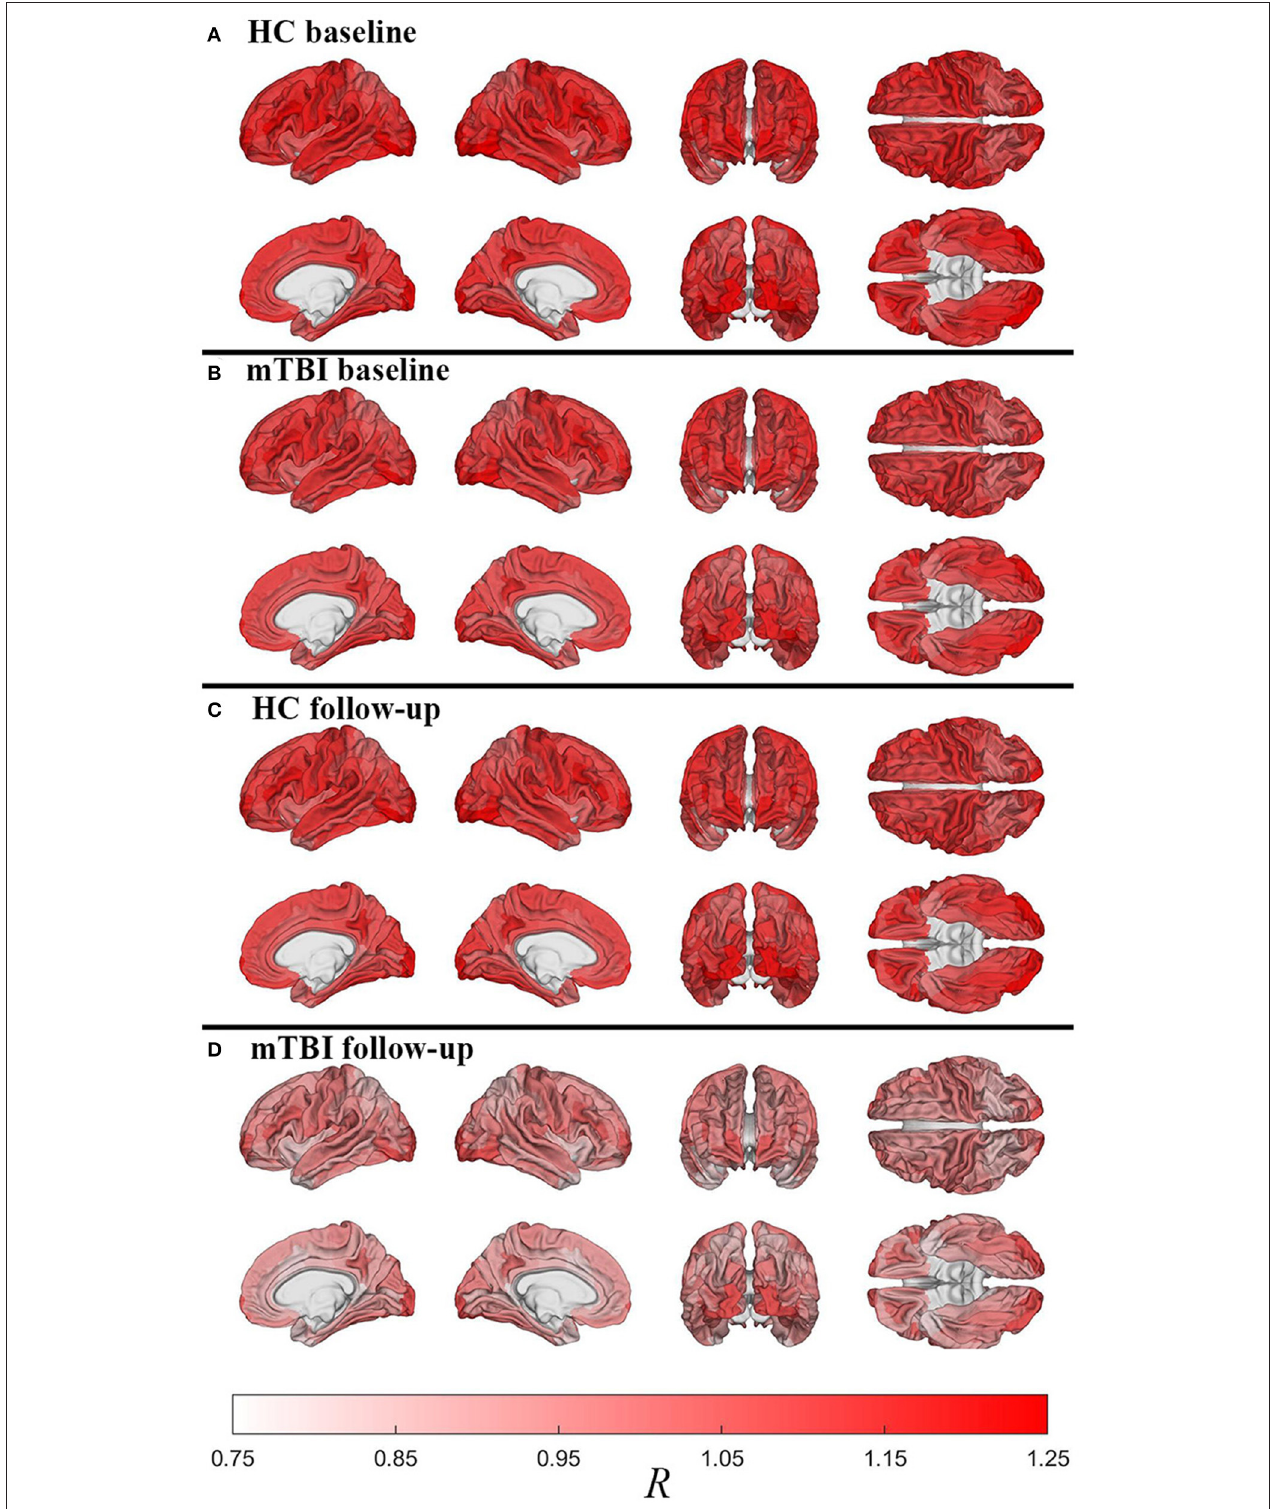
FIGURE 2 | Cortical maps of the relative myelin content ratio R averaged over subjects within each region of FreeSurfer’s cortical parcellation scheme. Shown are HCs [ (A) : baseline; (C) : follow-up) and mTBI participants [ (B) : baseline; (D) : follow-up). After accounting for age and sex effects, HCs have much more myelin than mTBI participants across the entire cortex, as expected based on Figure 1 . Similarly, within each group, there is more myelin at the first timepoint compared to the second timepoint, even after adjusting for individual interscan intervals. However, whereas HCs experience relatively modest decreases in myelin with time, there is considerably more such loss in mTBI participants, particularly in dorsolateral frontal, lateral temporal, and especially occipital regions.